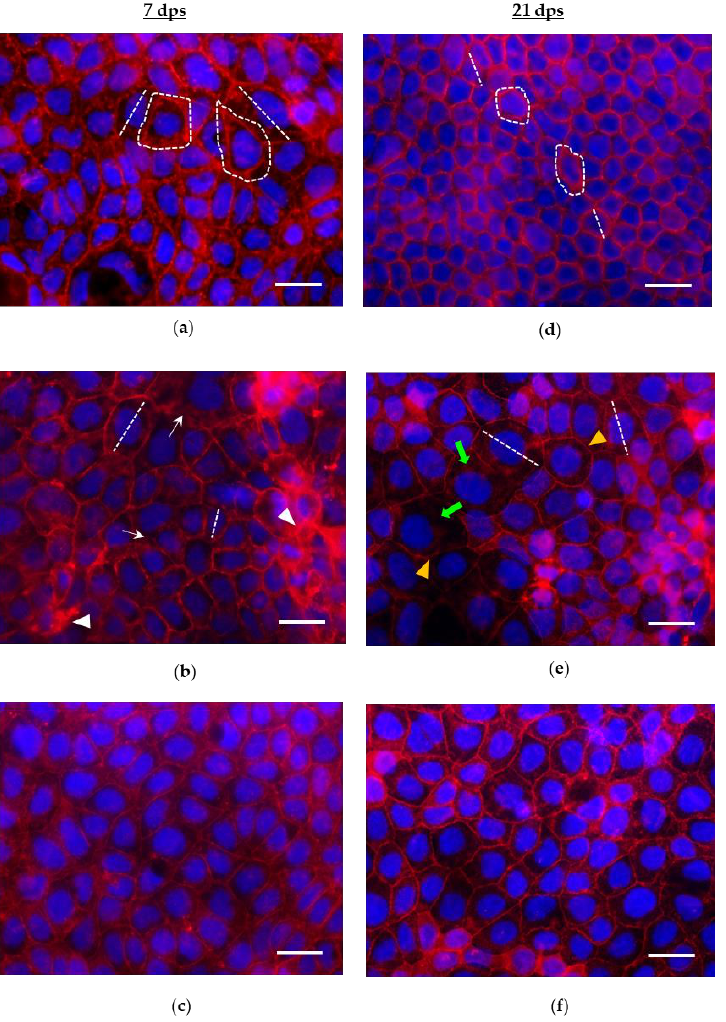
Figure 2. Phalloidin-TRITC/DAPI staining (merged images) of 7 and 21 dps Caco-2 monolayers treated with PMA (150 nM) or PMA+CAR (1 mM) for 48 h. ( a – c ): 7 dps monolayers; ( d – f ): 21 dps monolayers. ( b ): representative picture of 7 dps PMA-treated cells; white arrowheads and arrows indicate thickened and frayed F-actin rings, respectively; the monolayer architecture maintains the tumor-like organization as in the untreated control ( a ). ( e ): representative picture of 21 dps PMA- treated cells; actin rings appear thinned and discontinuous (yellow arrowheads); with respect to 21 dps untreated control ( d ), cells appear enlarged and irregularly roundish (green arrows). ( c,f ): in pictures both from 7 and 21 dps monolayers, concurrent exposure to PMA and CAR produces partial protection from the PMA-induced rearrangement/derangement of the actin cytoskeleton. In pictures, white dashed lines indicate representative cell diameters and perimeters designed to calculate the length, area, and fluorescence intensity of cells by applying ImageJ analysis software (see Materials and Methods for details). Unit areas: 450 × 600 µ m; Scale bar: 100 µ